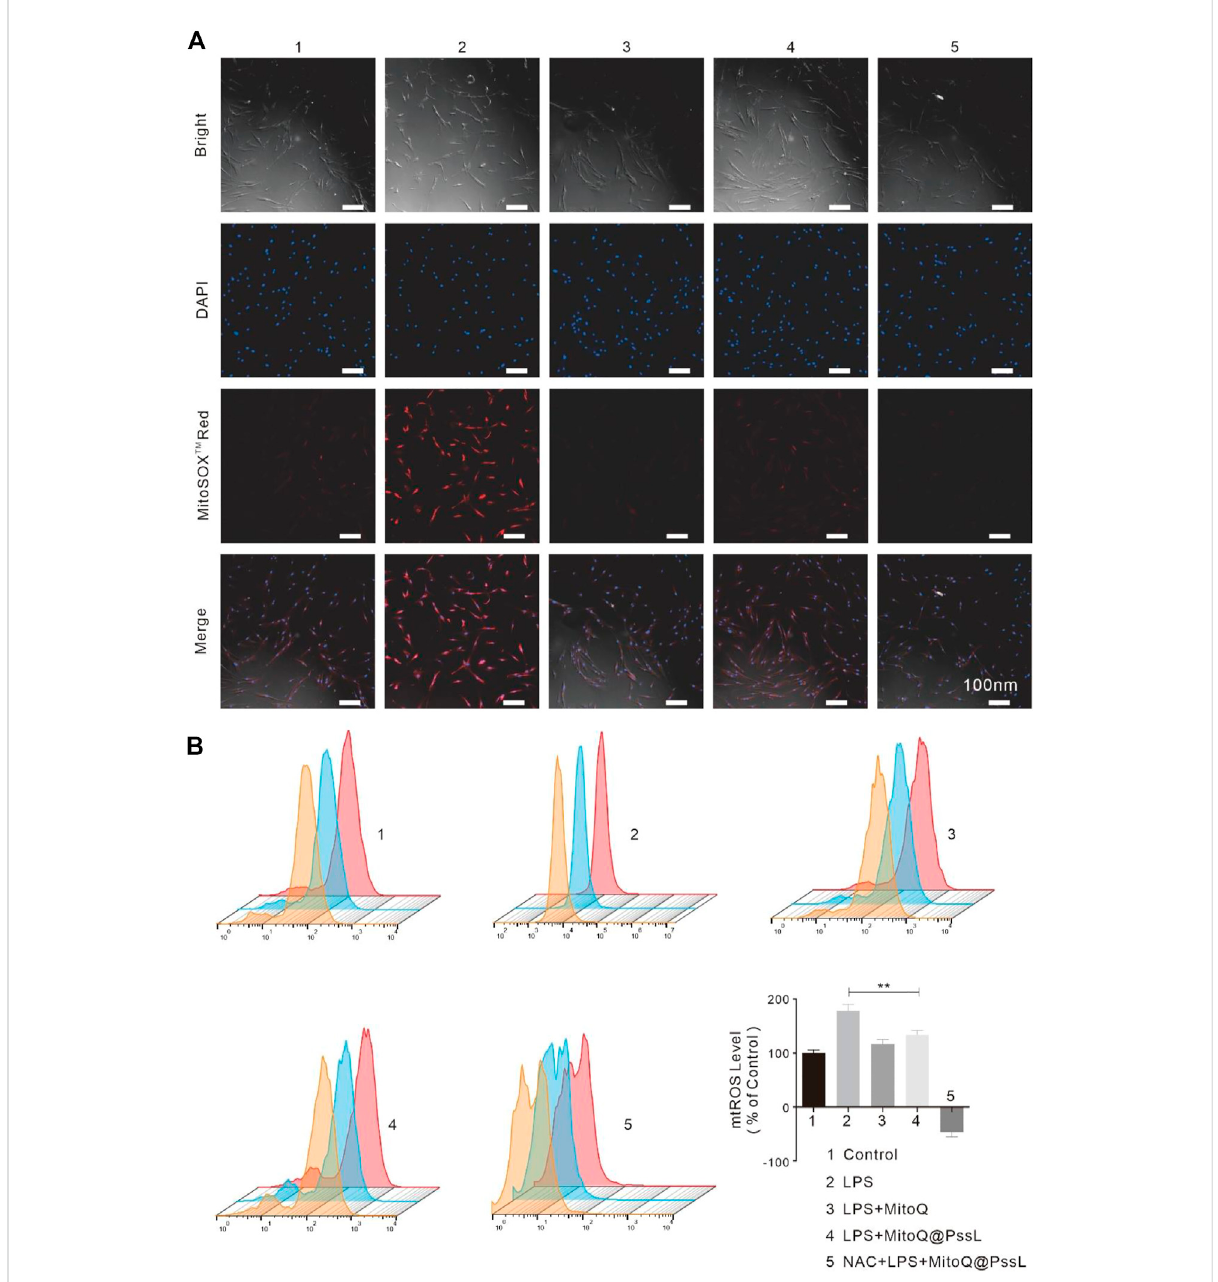
FIGURE 3 ROS regulation of hPDLSCS treated with MitoQ@PssL NPs (1: Control, 2: LPS, 3: LPS + MitoQ, 4: LPS + MitoQ@PssL NPs, and 5: NAC + LPS + MitoQ@PssL NPs). (A) Typical fl uorescence images of hPDLSCs. (B) Flow cytometry and quantitative measurement of mtROS formation (MitoSOXTMRED) of hPDLSCs. (** means p <